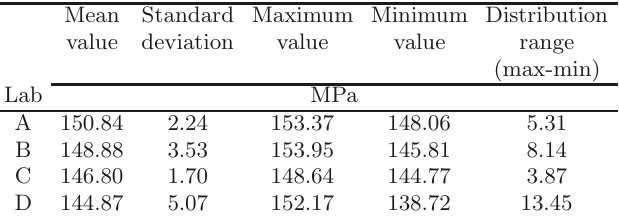
Table 4. Distribution ranges of flexural strengths ( σ f ) for the participant laboratories.